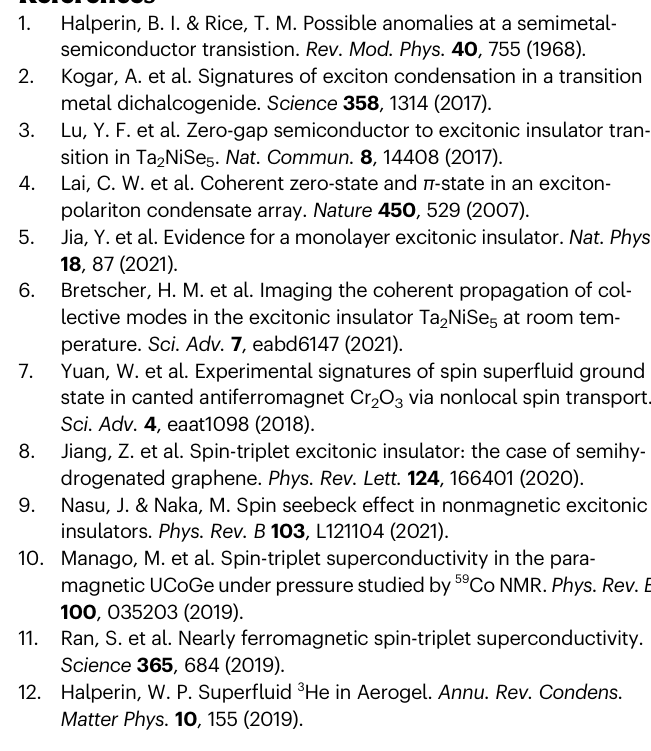
results show that the phase transitions occur from the vacuum ground state to two kinds of exciton condensations with increasing magnetic fi elds. As schematically shown in Fig. 4b, the exciton condensation 1 (EC1) is a spatially uniform exciton condensation made of a mixture of (cid:1) = a ∣ 0 i + b ∣ 1 i + c ∣ 2 i . EC1 is followed by the all the exciton states as ∣ ϕ EC1 appearance of exciton condensation 2 (EC2) with increasing magnetic fi elds. In EC2, both order parameters of exciton superlattice and